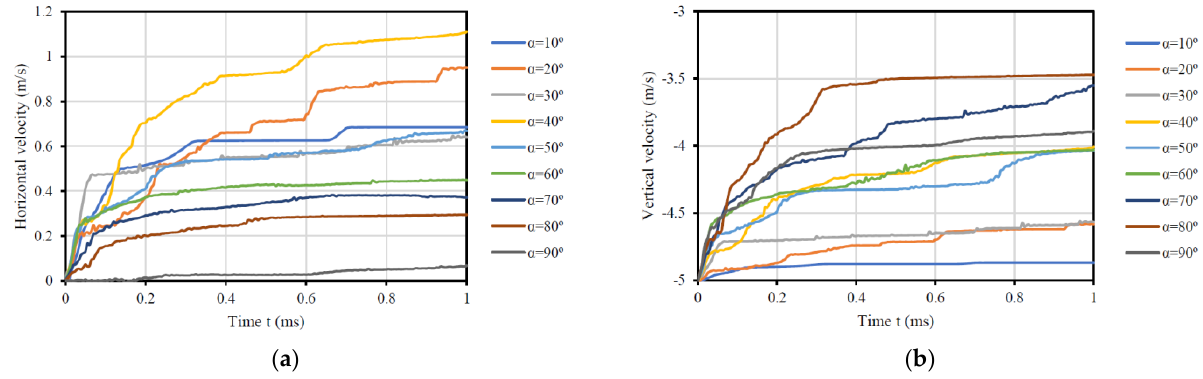
Figure 18. Evolution of the projectile velocity with different impact angles: ( a ) horizontal; ( b ) vertical.